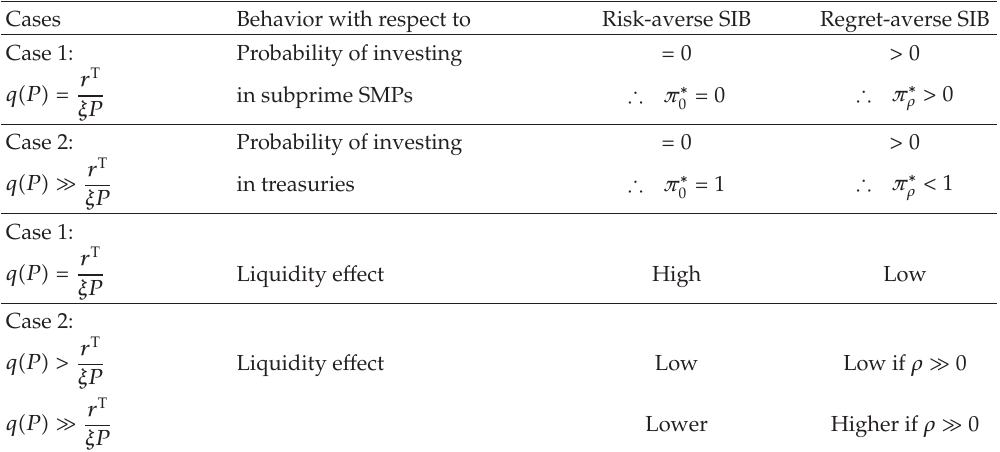
Table 8: E ff ect of regret on risk allocation and